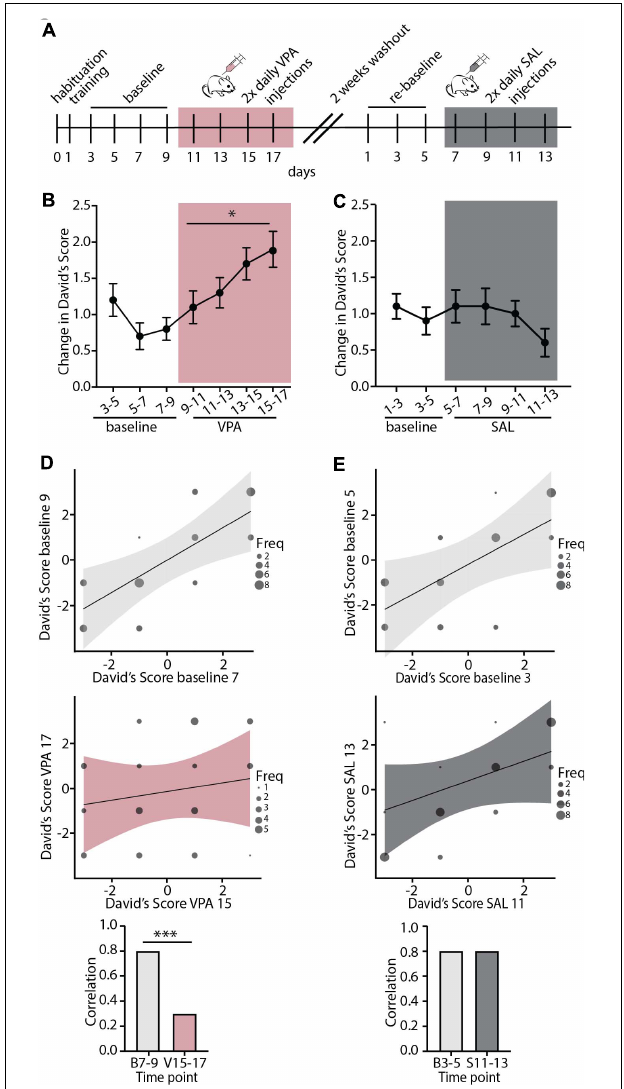
FIGURE 3 | Valproic Acid, a pharmacological modulator of cortical plasticity, destabilizes hierarchy stability. (A) Timeline showing habituation and training, followed by baseline testing and testing under Valproic Acid (VPA) 2x daily injection followed by 2 weeks of drug wash-out. Mice were then re-tested for a baseline period and a saline (SAL) 2x daily injection control treatment. (B) VPA treatment increased change in DSs separated by a day, an indication of increased hierarchy instability while (C) injection with SAL had no effect on hierarchy stability (VPA: generalized linear model, ∗ p = 0.02 SAL: generalized linear model, p = 0.68, n = 40 mice in 10 cages). (D,E) Baseline testing sessions separated by a day show highly correlated DS values ( D,E, top) while post-VPA treatment DS correlations dissolve ( D, middle). SAL treated mice retain correlated DSs ( E, middle). Baseline DSs are significantly more correlated than DSs following VPA treatment ( D , bottom, Pearson and Filon’s z, ∗∗∗ p = 0.0005) while SAL treatment does not affect DS correlations ( E , bottom, p =